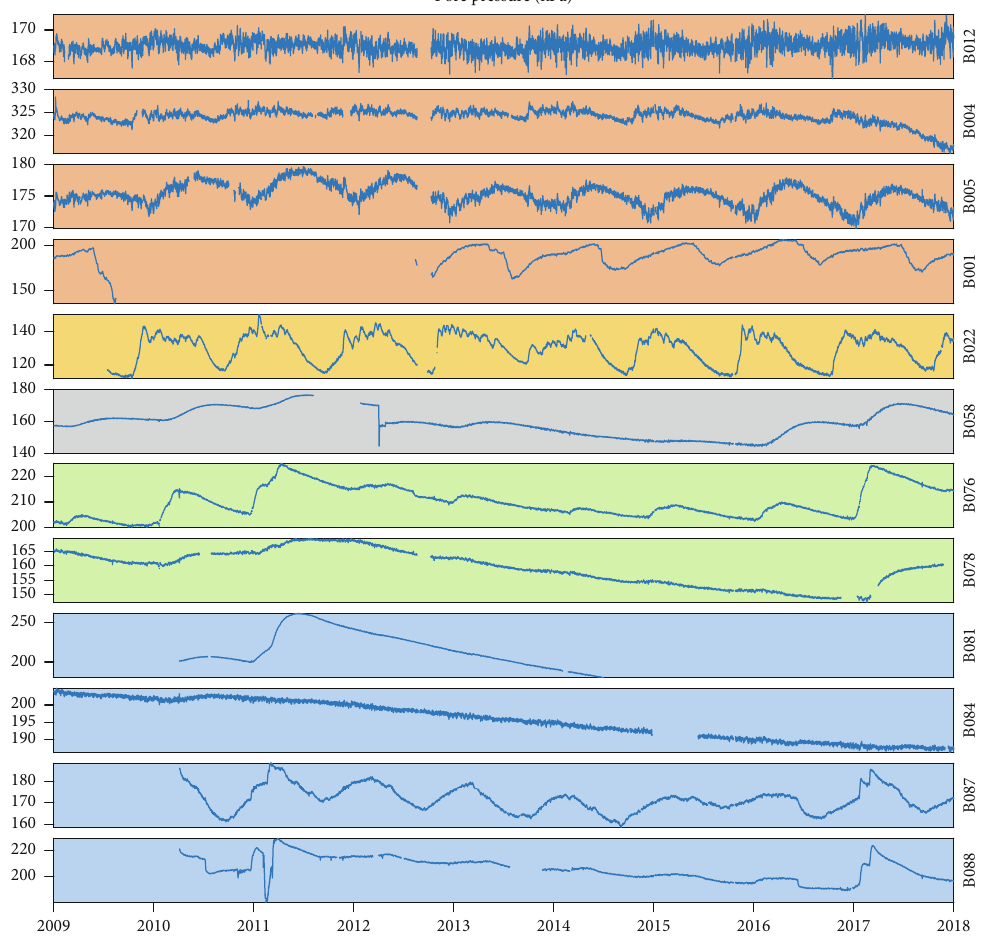
Figure 4: Pore pressure values over time for all boreholes. Pore pressures are downsampled by 100. Background colors represent regions determined by geographic locality and similarity of local